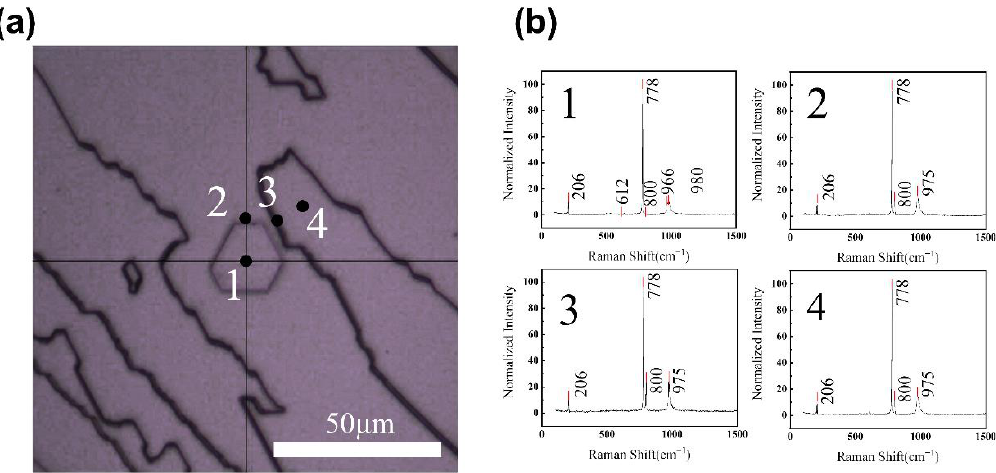
Figure 2. ( a ) The Nomarski photographs and ( b ) Raman spectra of the crystal in the local area of a sample of T g = 1650 ◦ C.